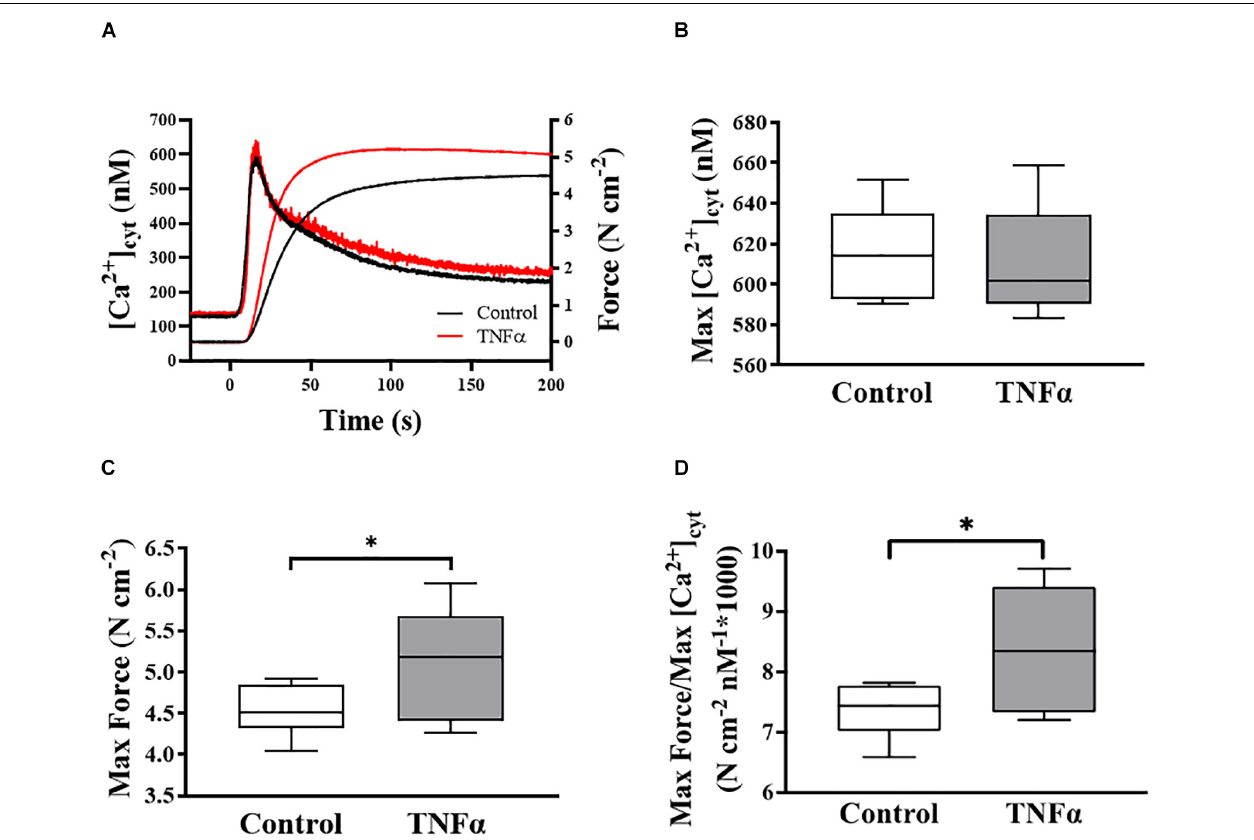
FIGURE 2 | Representative tracings of simultaneous measurements of [Ca 2 + ] cyt and force responses of ASM to ACh stimulation (EC 50 ) (A) . Maximum specific force (C) and static Ca 2 + sensitivity of ASM significantly increased (D) with TNF α exposure, while there was no significant change in maximum [Ca 2 + ] cyt (B) ( p > 0.05), compared to controls [summarized as medians and interquartile range (IQR)]. Data were analyzed using a one-way repeated measure ANOVA. Significance was considered at p < 0.05 [ ∗ compared with TNF α ; n = 6 (number of animals)].